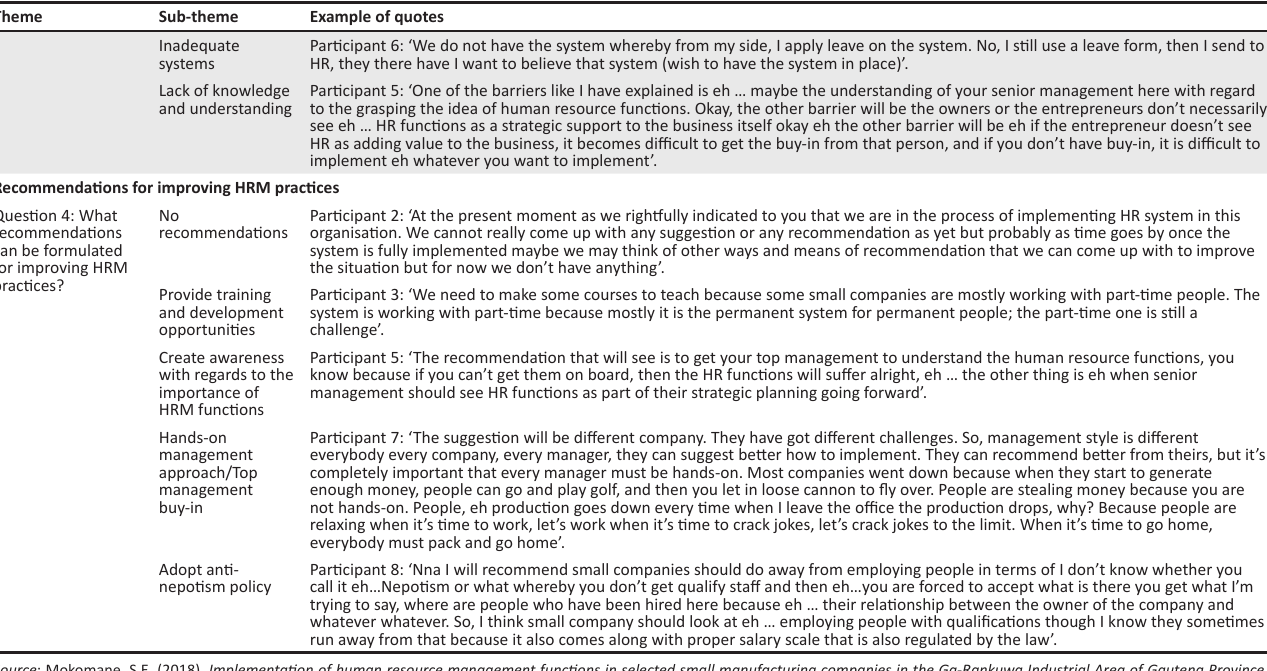
TABLE 3: Summary of the core themes about implementation and perceived importance of human resource management functions as well as perceived limitations or barriers to effective human resource management implementation in small manufacturing